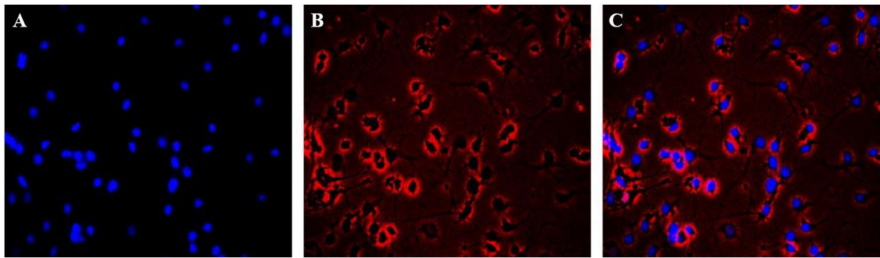
Figure 2. Primary cultured cortical neuronal cells were identified by β -III Tubulin. ( A ) The nucleus was stained with Hoechst 33258. ( B ) Immunocytochemical signals (red) under fluorescence microscope. ( C ) A merged image ( A and B ).